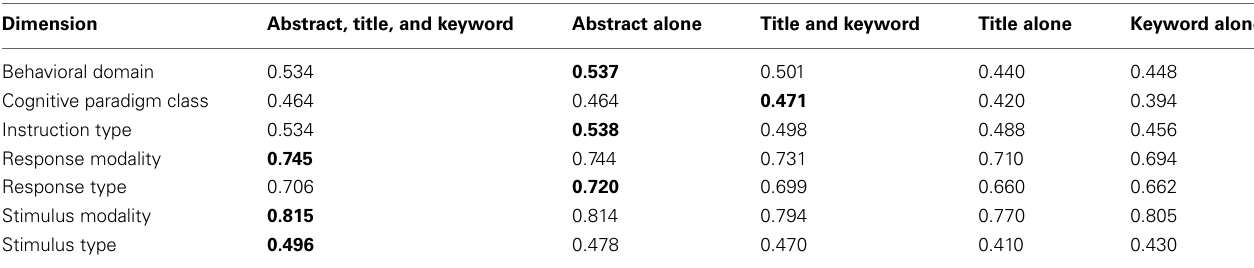
Table 3 | Cross-corpora comparison